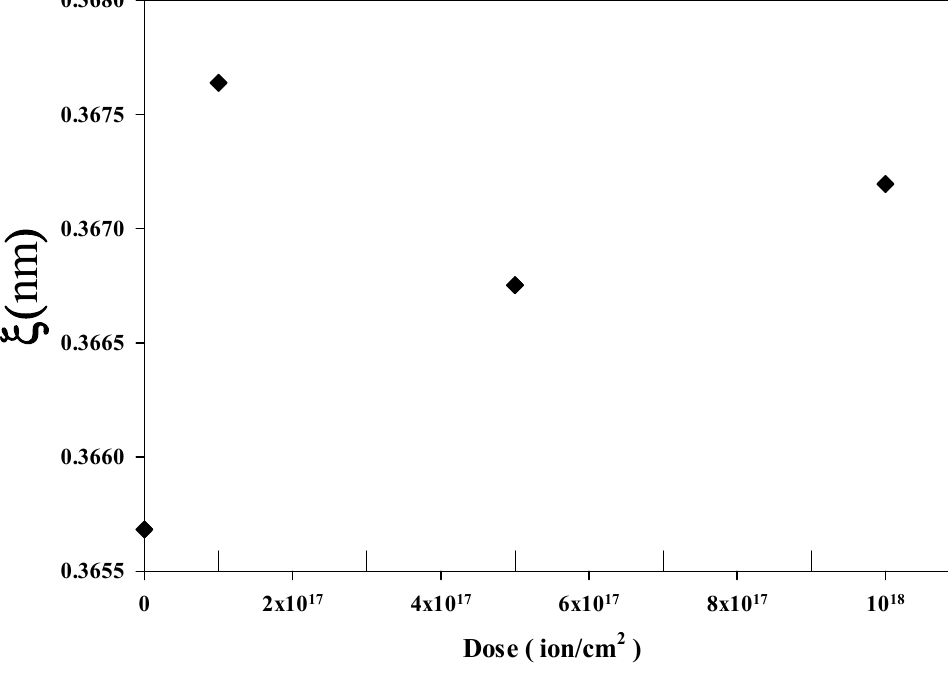
Figure 5. The correlation lengths versus argon ion doses for unimplanted and implanted samples.